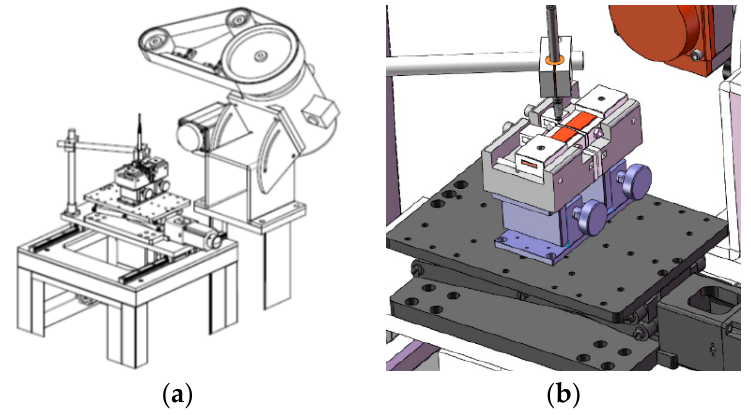
Figure 6. Schematic diagram of the friction tester measuring wear in situ: ( a ) schematic diagram of the complete appearance of the friction tester; ( b ) local enlargement of in situ measurement.